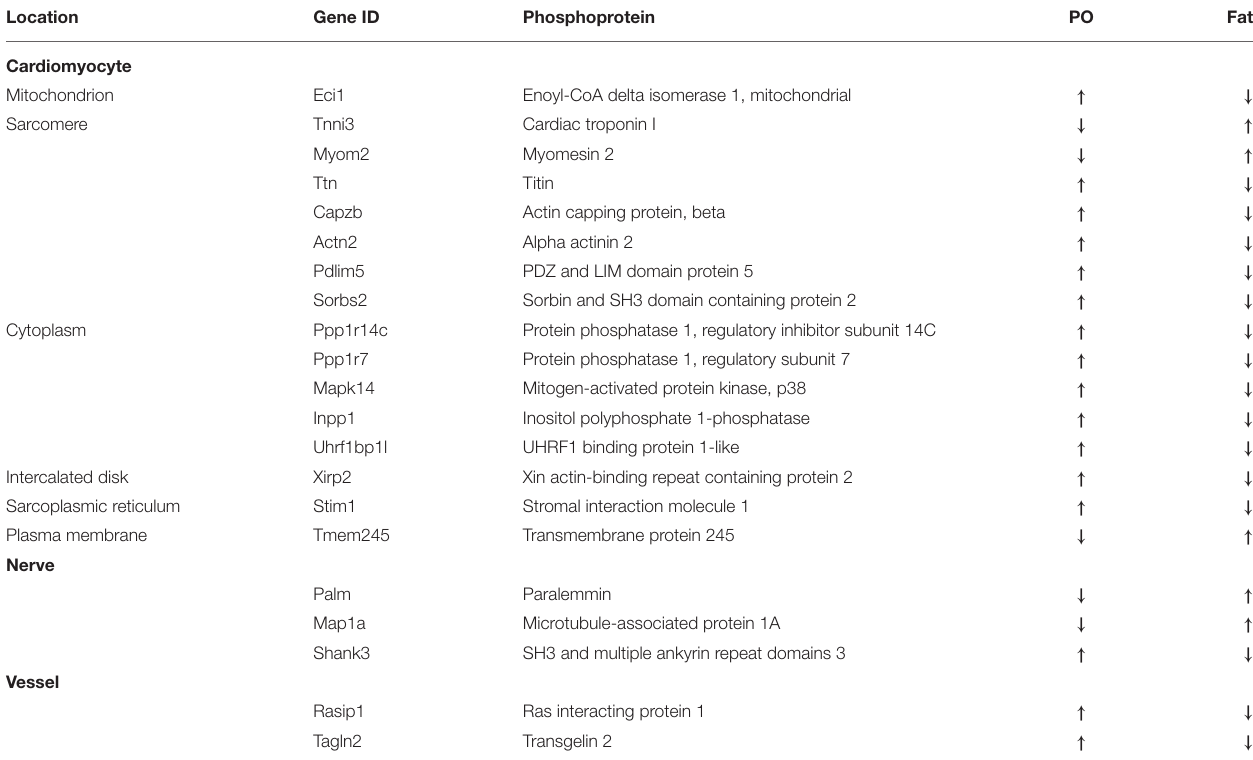
TABLE 2 | Expression of phosphoproteins regulated by endogenous n-3 PUFAs.